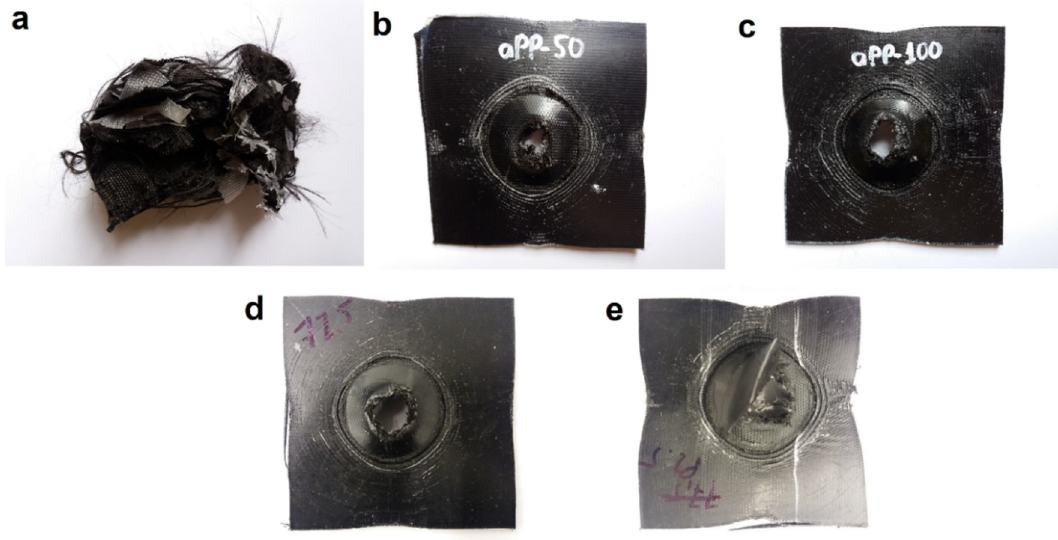
Figure 12. Typical impact failure behavior of ( a ) rPP, ( b ) APAO-50, ( c ) APAO, ( d ) APAO-2F and ( e ) APAO-3F.